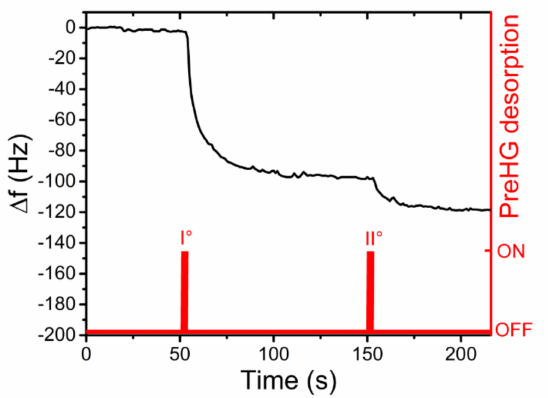
Figure 11. QCM frequency shift, following the desorption of the preconcentrator, after it was exposed for 60 min at a concentration of 65 µ g/m 3 of Hg 0 .